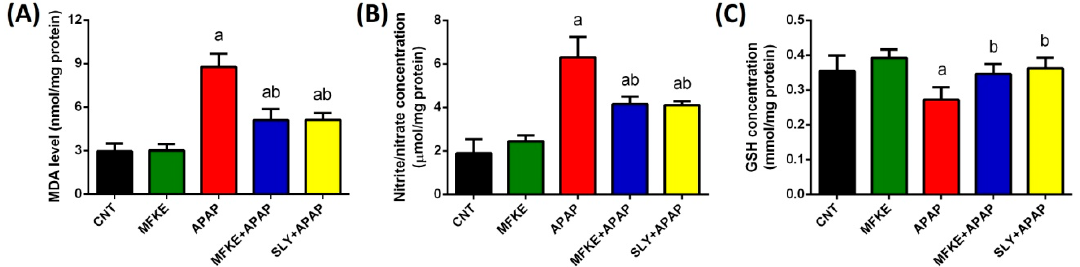
Figure 2. The effect of Myristica fragrans kernel extract (MFKE) on serum liver function markers in rats treated with paracetamol (APAP)-induced liver toxicity. Data are expressed as mean ± SD ( n = 7); a p < 0.05 vs. control rats; b p < 0.05 vs. APAP-treated rats using Tukey’s post hoc test. ( A ) Alanine aminotransferase, ( B ) Aspartate aminotransferase, ( C ) Alkaline phosphatase and ( D ) Total bilirubin.